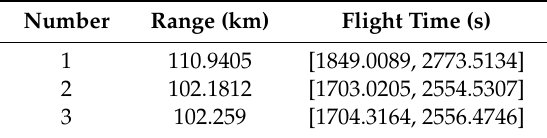
Table 11. Coordinates of the starting and target points of all UAVs (case 2).